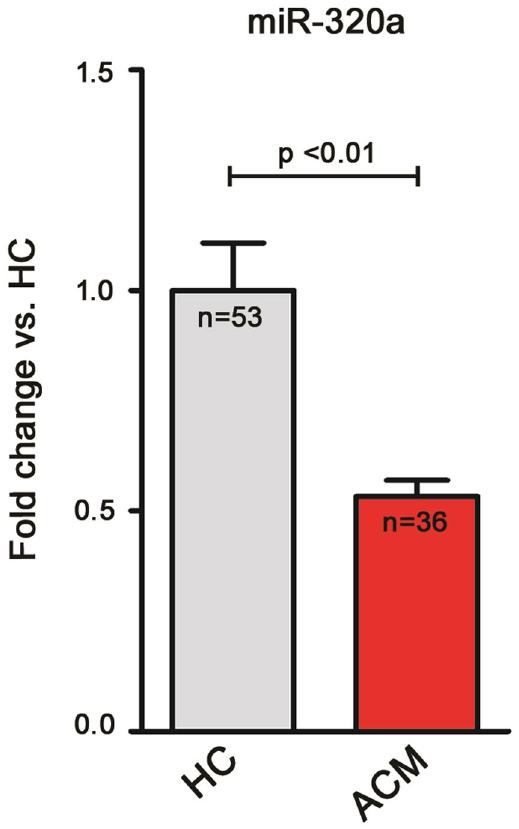
Figure 2. miR-320a shows a lower plasma expression in Arrhythmogenic CardioMyopathy (ACM) patients when compared to Healthy Controls (HC). Relative expression of plasma miR-320a in ACM patients (n = 36) with respect to HC (n = 53); the mean expression value in HC was arbitrarily set to one (HC 1.00 ± 0.11; ACM 0.53 ± 0.04; p < 0.01,